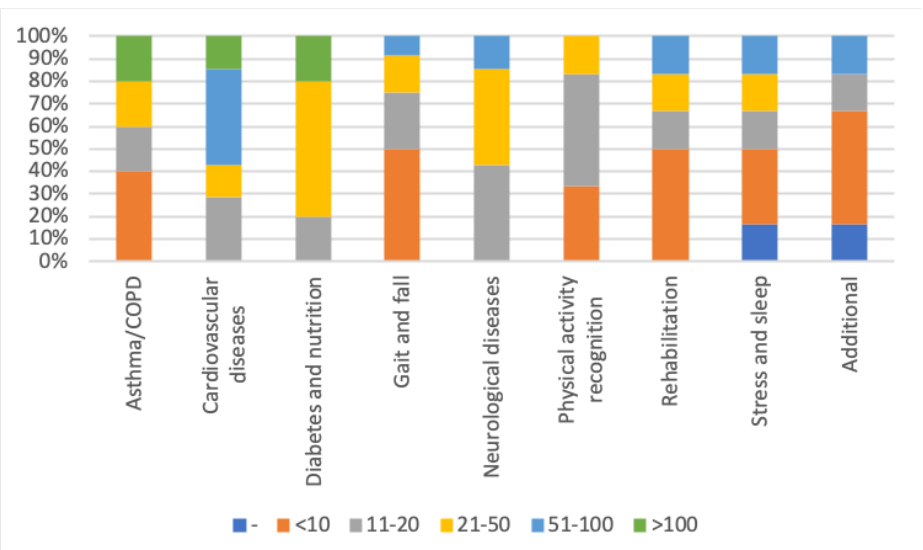
Figure 7. Distribution of the number of participants per article category. - denotes studies which did not provide information on number of